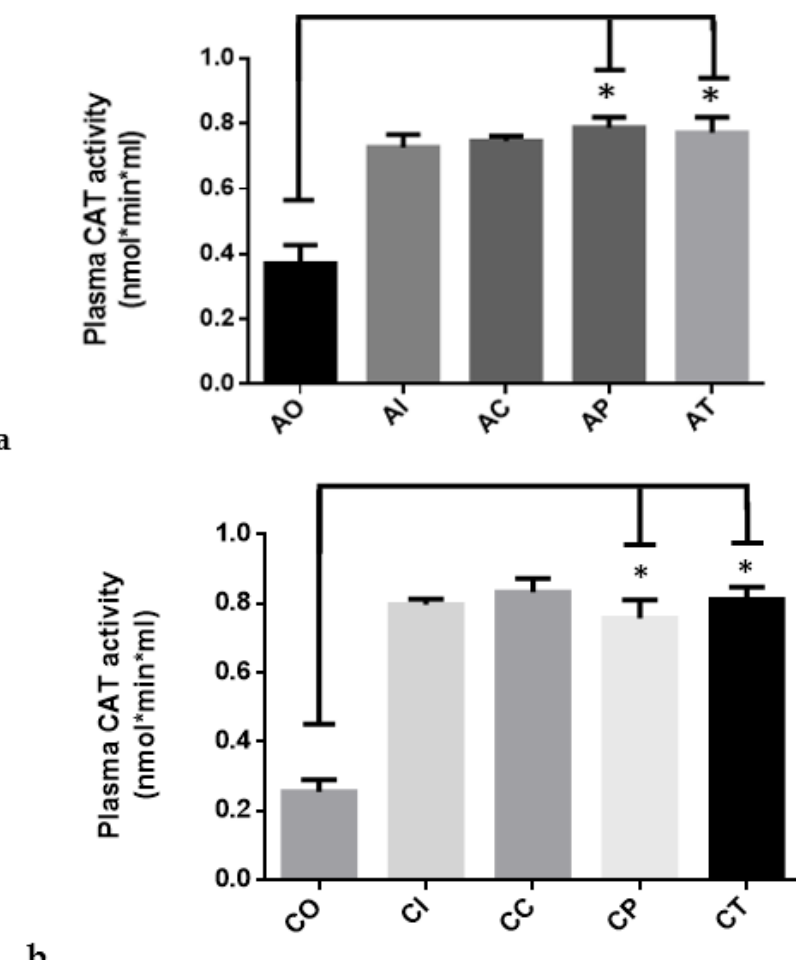
Figure 1. The catalase activity in rats exposed to ozone during the acute and chronic phases: ( a ) the preventive and therapeutic administration of dietary curcumin (5.6 mg/Kg) resulted in significantly increased activity (* p < 0.01) when evaluated at the end of the acute phase when compared to the control group exposed to ozone; acute O 3 (AO), acute intact (AI), acute CUR (AC), acute preventive (AP), acute therapeutic (AT); ( b ) the effect of curcumin, when evaluated at the end of the chronic phase, maintained the same profile as observed in the acute phase, with a significance of p < 0.01 (*); chronic O 3 (CO), chronic intact (CI), chronic CUR (CC), chronic preventive (CP), chronic therapeutic (CT).